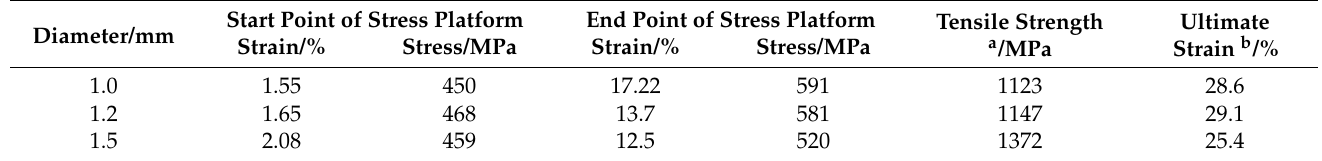
Figure 4. The tensile stress–strain curve of ECC. Table 2. The main mechanical performance of the SMA fibers with different diameters.